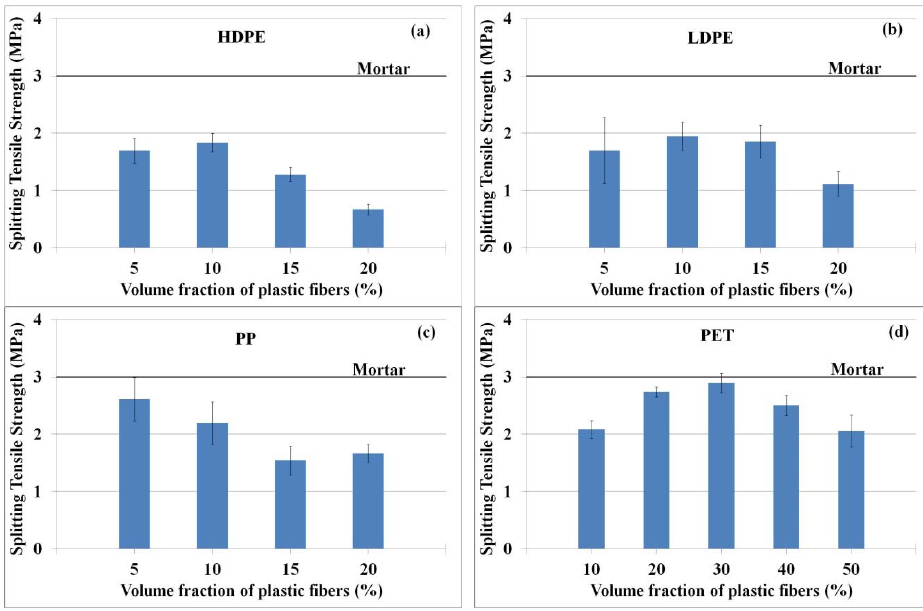
Figure 7. Splitting tensile strengths of produced concrete; ( a ) HDPE, ( b ) LDPE, ( c ) PP, and ( d ) PET fibers. The splitting tensile strength of mortar (control sample) is in the solid line.